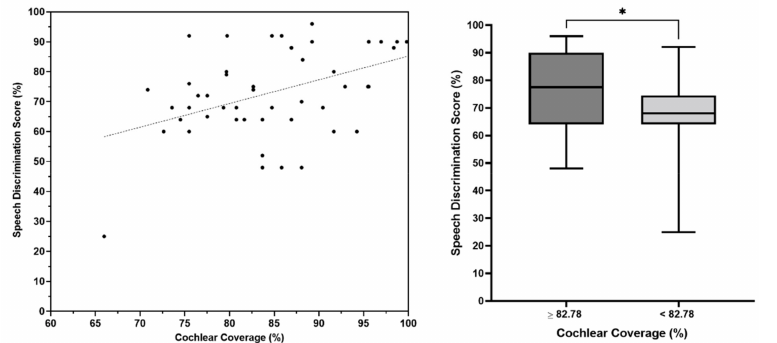
Figure 2. Left panel shows a regression analysis comparing cochlear coverage with speech discrim- ination score (SDS). The right panel shows the SDS in children with cochlear coverage ≥ 82.78% compared with children with cochlear coverage < 82.78%. * indicates statistically significant p -value ( p =